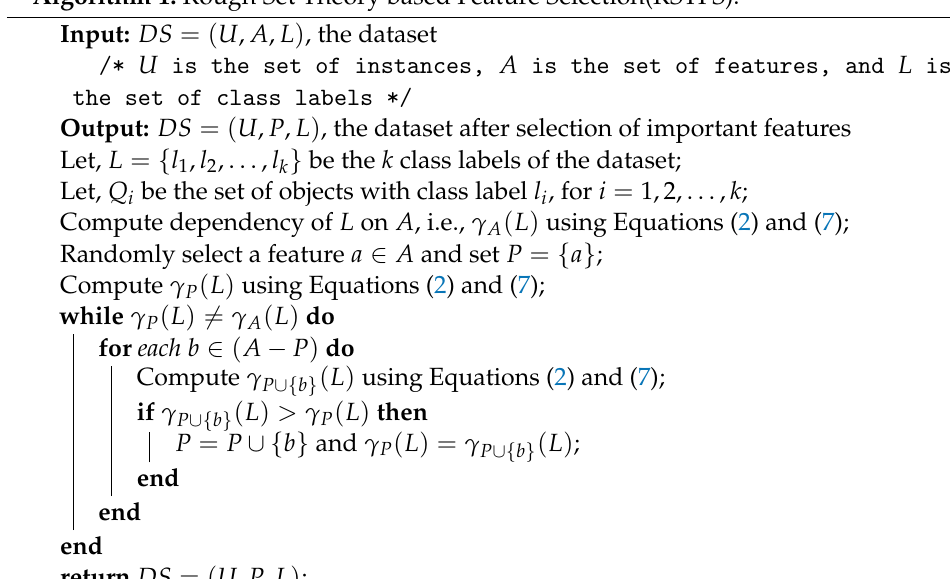
Algorithm 1: Rough Set Theory based Feature